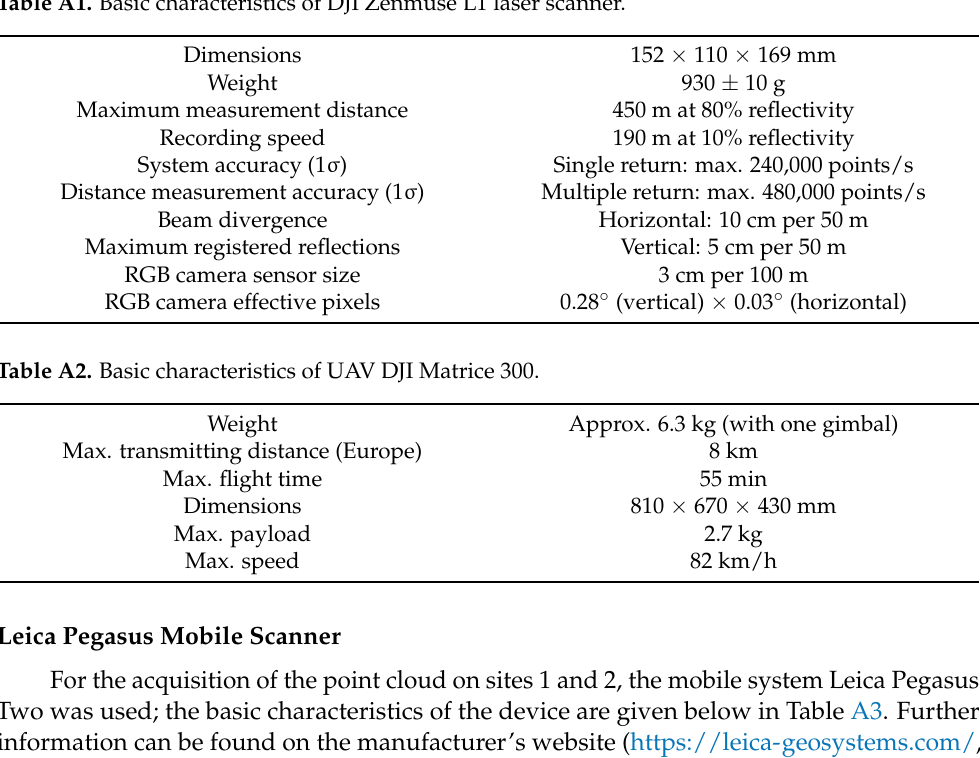
Table A1. Basic characteristics of DJI Zenmuse L1 laser scanner.